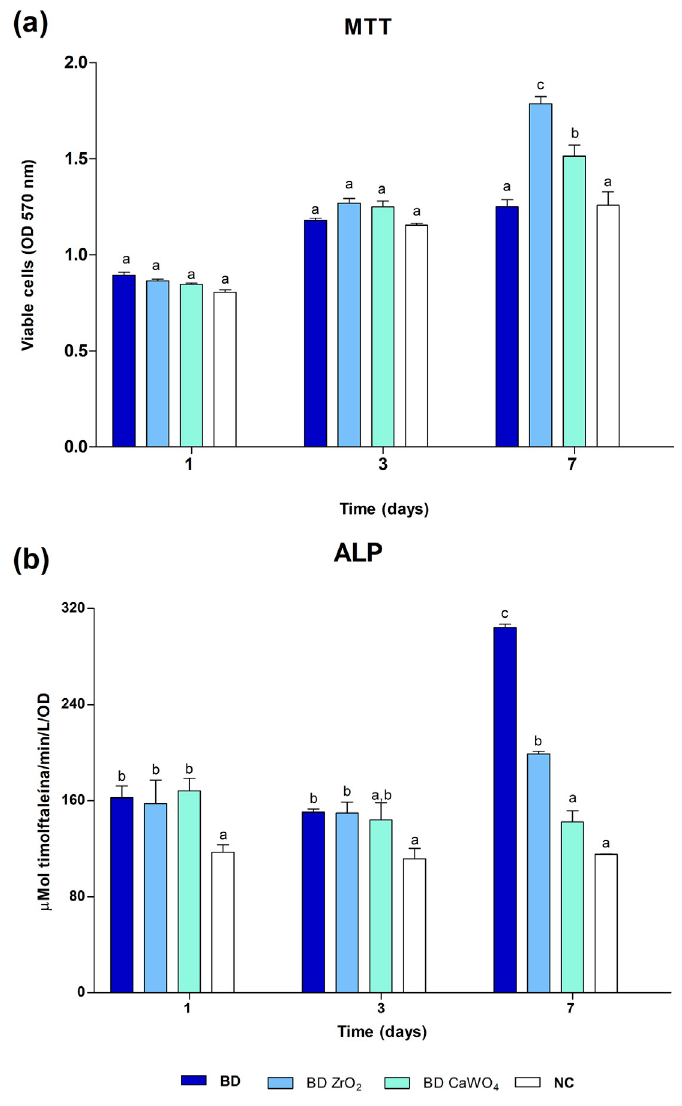
Figure 4- Saos-2 cell viability evaluated by methyl-thiazol-tetrazolium (MTT) assay (a) and alkaline phosphatase (ALP) activity (b) evaluated after exposure to BD, BD ZrO ALP activity of cement groups at 1, 3 and 7 days was similar to or greater than the control group. At 7 days, the highest ALP activity was detected for Group BD followed by Groups BD ZrO the control group. Bars with different letters represent significant differences between groups in each period. BD=Biodentine; BD ZrO with addition of 15% zirconium oxide; BD CaWO